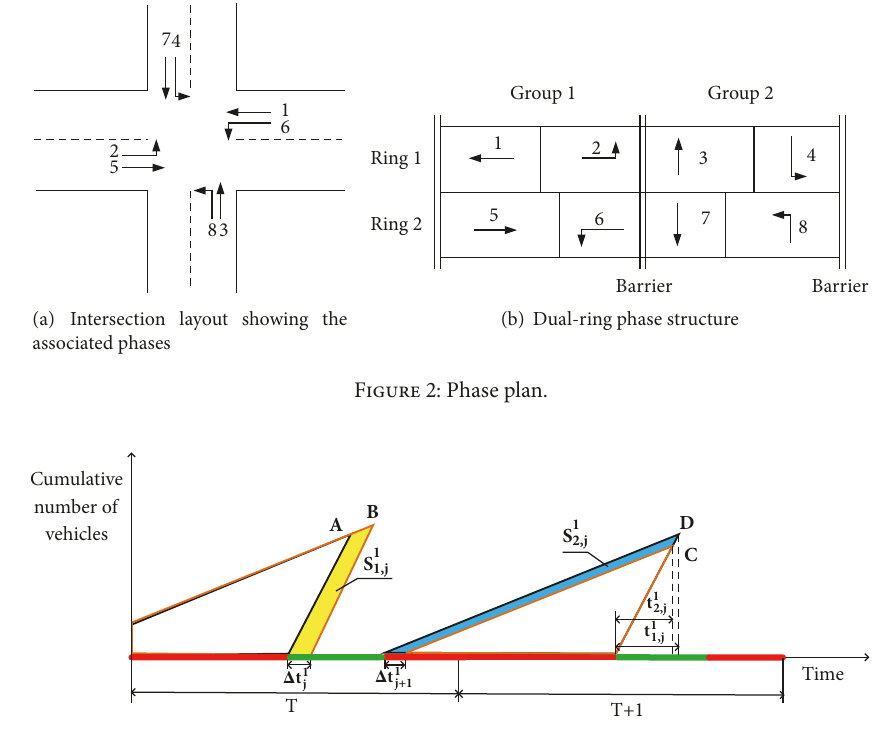
Figure 3: Calculation of vehicular delay for movement j in scenario